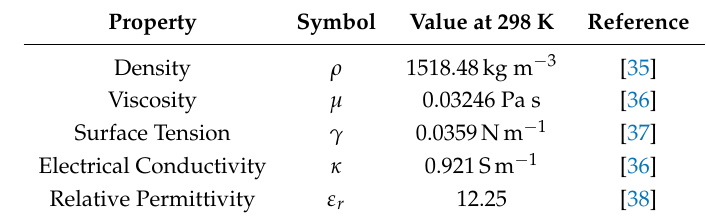
Table 1. Material properties for EMI-Im.